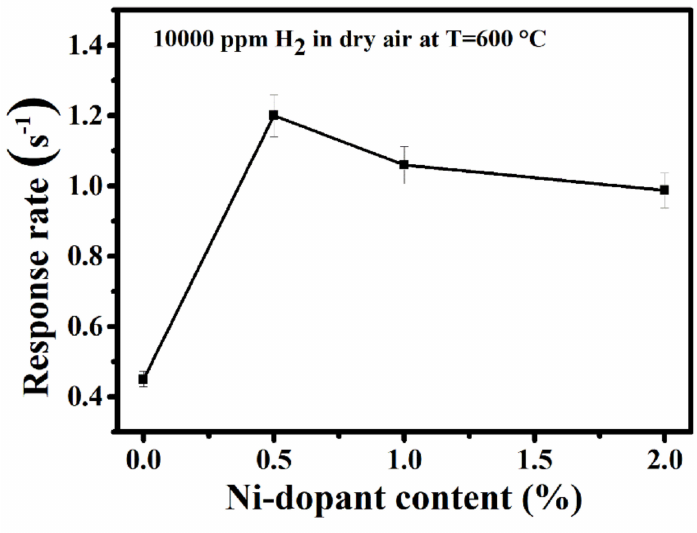
Figure 6. Response rate of undoped TiO 2 and all Ni-doped TiO 2 toward 10,000 ppm H 2 in dry air at 600 ◦